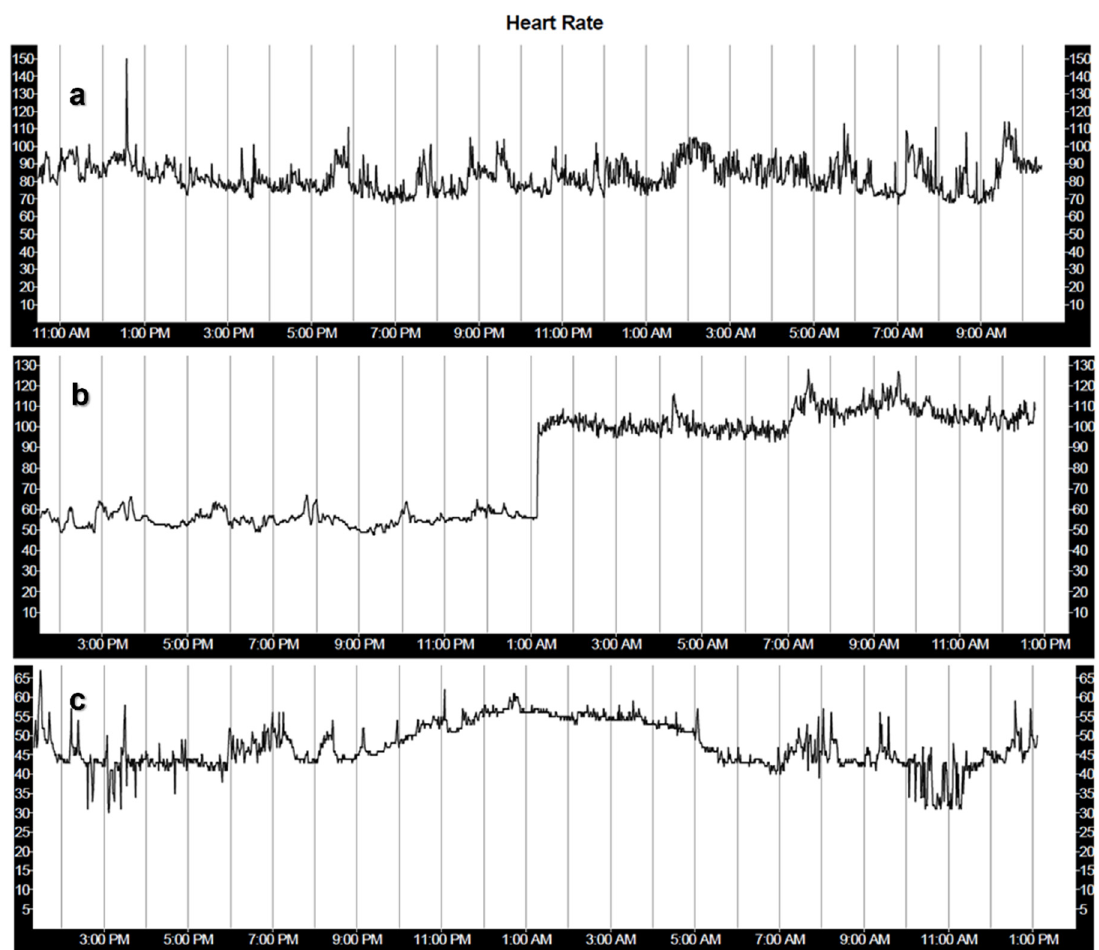
Figure 4. Holter monitor heart rate tracings of patients with abnormal 48 h HR/HRV. ( a ) paroxysmal supraventricular tachycardia—on the first day of monitoring, the heart rate suddenly increased to 150 bpm for a few minutes, with abrupt termination. ( b ) paroxysmal atrial fibrillation. Normal sinus rhythm in the first half of the tracing, with sudden, sustained increase in the heart rate for the second half—the arrhythmia did not terminate during the monitoring period. ( c ) sick sinus syndrome. The heart rate is low (30–65 bpm). The diurnal variation is abnormal, lower heart rate during daytime and increased heart rate at night.